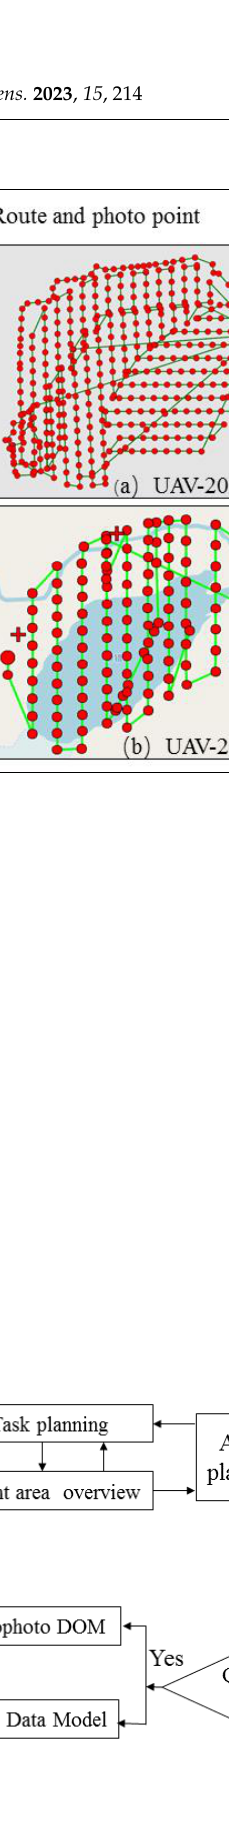
Table 2. UAV aerial survey details.